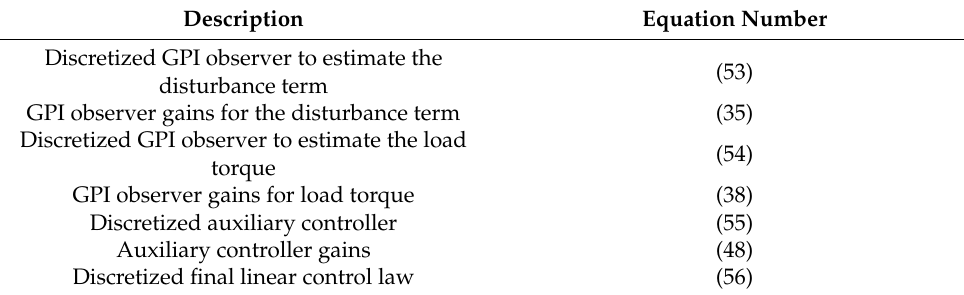
Table 1. Equations required to control the entire